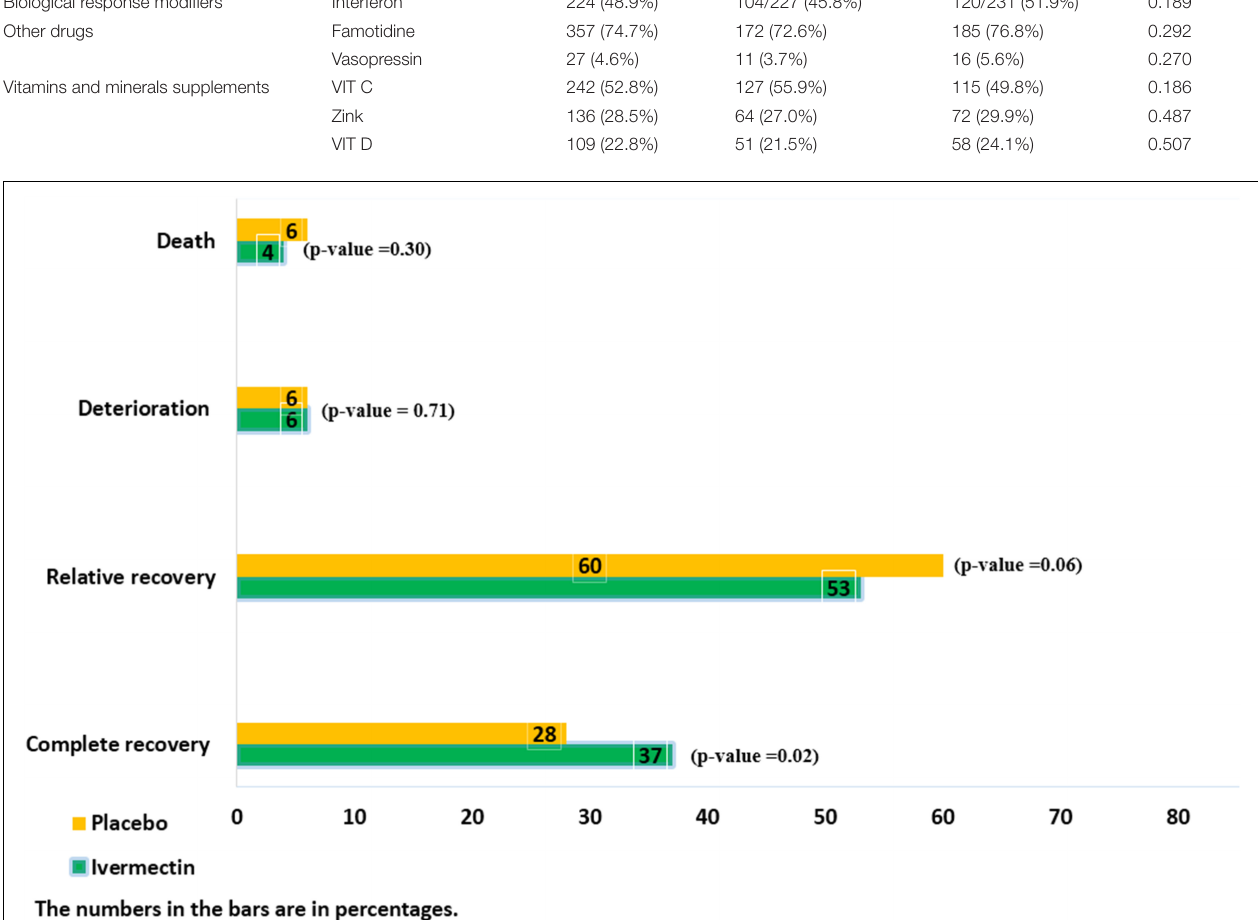
FIGURE 2 | The main outcomes in inpatients with